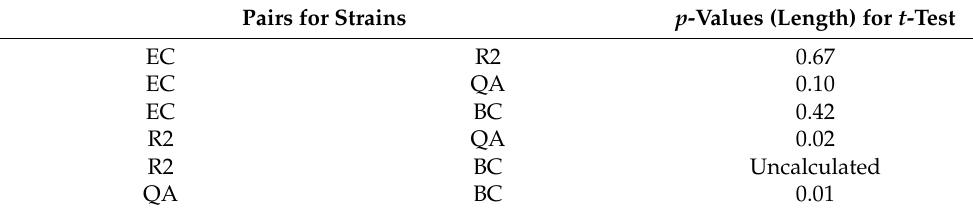
Figure 6. Automatically measured cell area vs. cell length for each strain. More than 30 cells are measured for each yeast strain (EC ( A ), R2 ( B ), QA ( C ), and BC ( D )). Table 1. p -value for statistical differences evaluation. Table 2. p -value for statistical differences